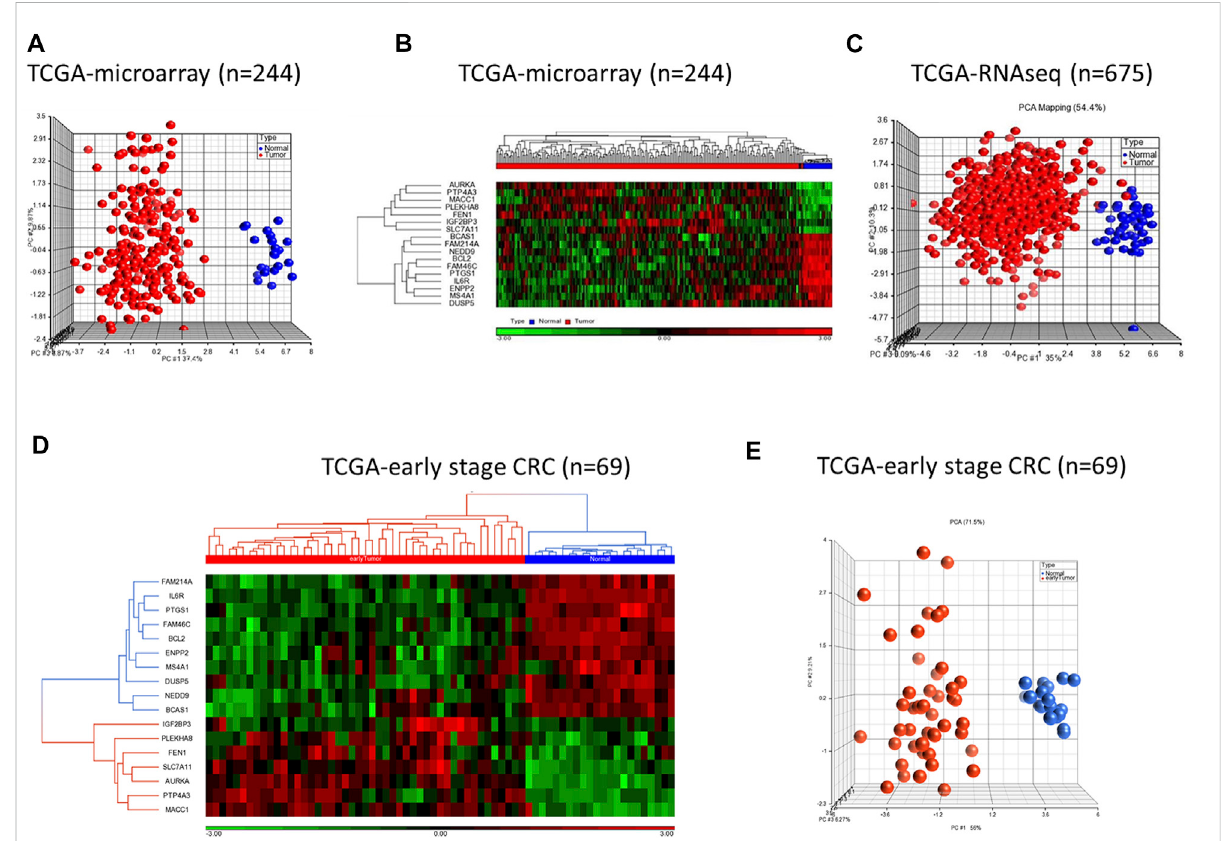
FIGURE 3 PCA and hierarchical clustering analyses using 17-gene signature on the TCGA microarray dataset ( n = 244) (A – B) and TCGA RNA-sequencing dataset ( n = 675) (C) . The hierarchical clustering and PCA analyses using the 17-gene signature on early stage CRC data from TCGA ( n = 69) (D – E). The analyses clearly distinguished patients as either CRC or normal controls on all datasets. Red and blue indicate tumor and normal samples, respectively.